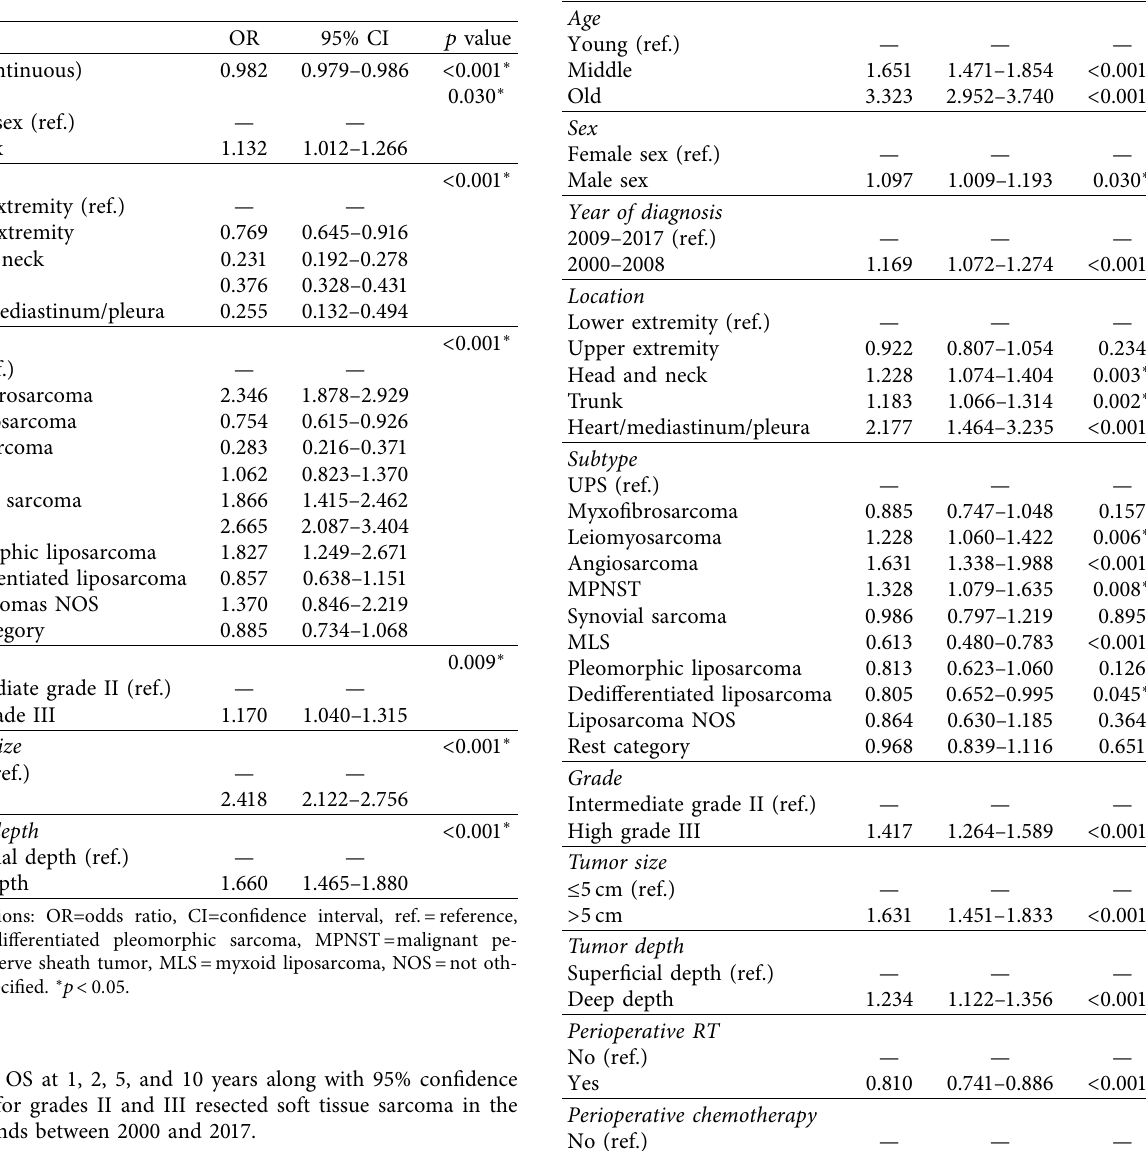
Table 4: Estimated odds ratio (OR) along with 95% confidence interval (CI) estimated from univariable logistic regression models on the association between patient and tumor factors and the chance of receiving perioperative radiotherapy for grade II and III resected soft tissue sarcoma in the Netherlands between 2000 and 2017.